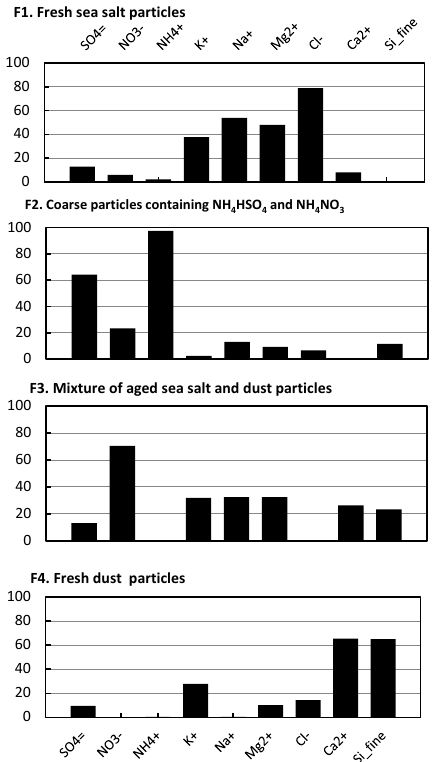
Figure 8. PMF-resolved source profiles (% of total species) for coarse-mode data. PM 2.5 Si as a surrogate for bulk dust particles is also included as input data.